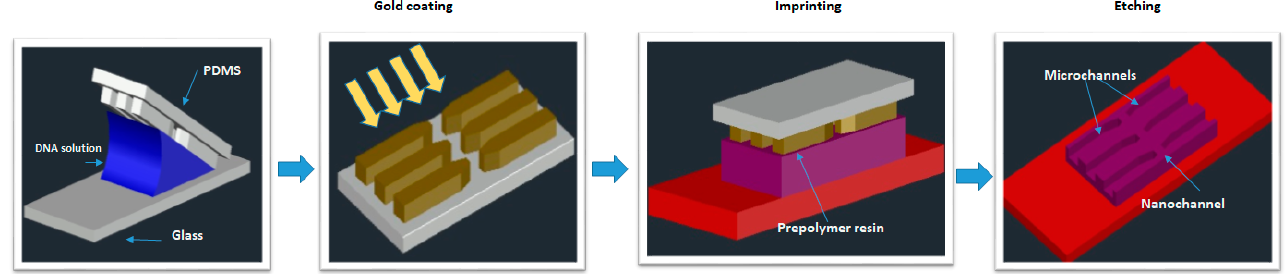
Figure 9. Design and operation of a NEP platform. The Fabrication process of the NEP device. Schematic of the PDMS lid on the NEP chip. The nanochannel has a diameter of 90 nm and length of 3 μ m. Figure has been redrawn from ref. [108].